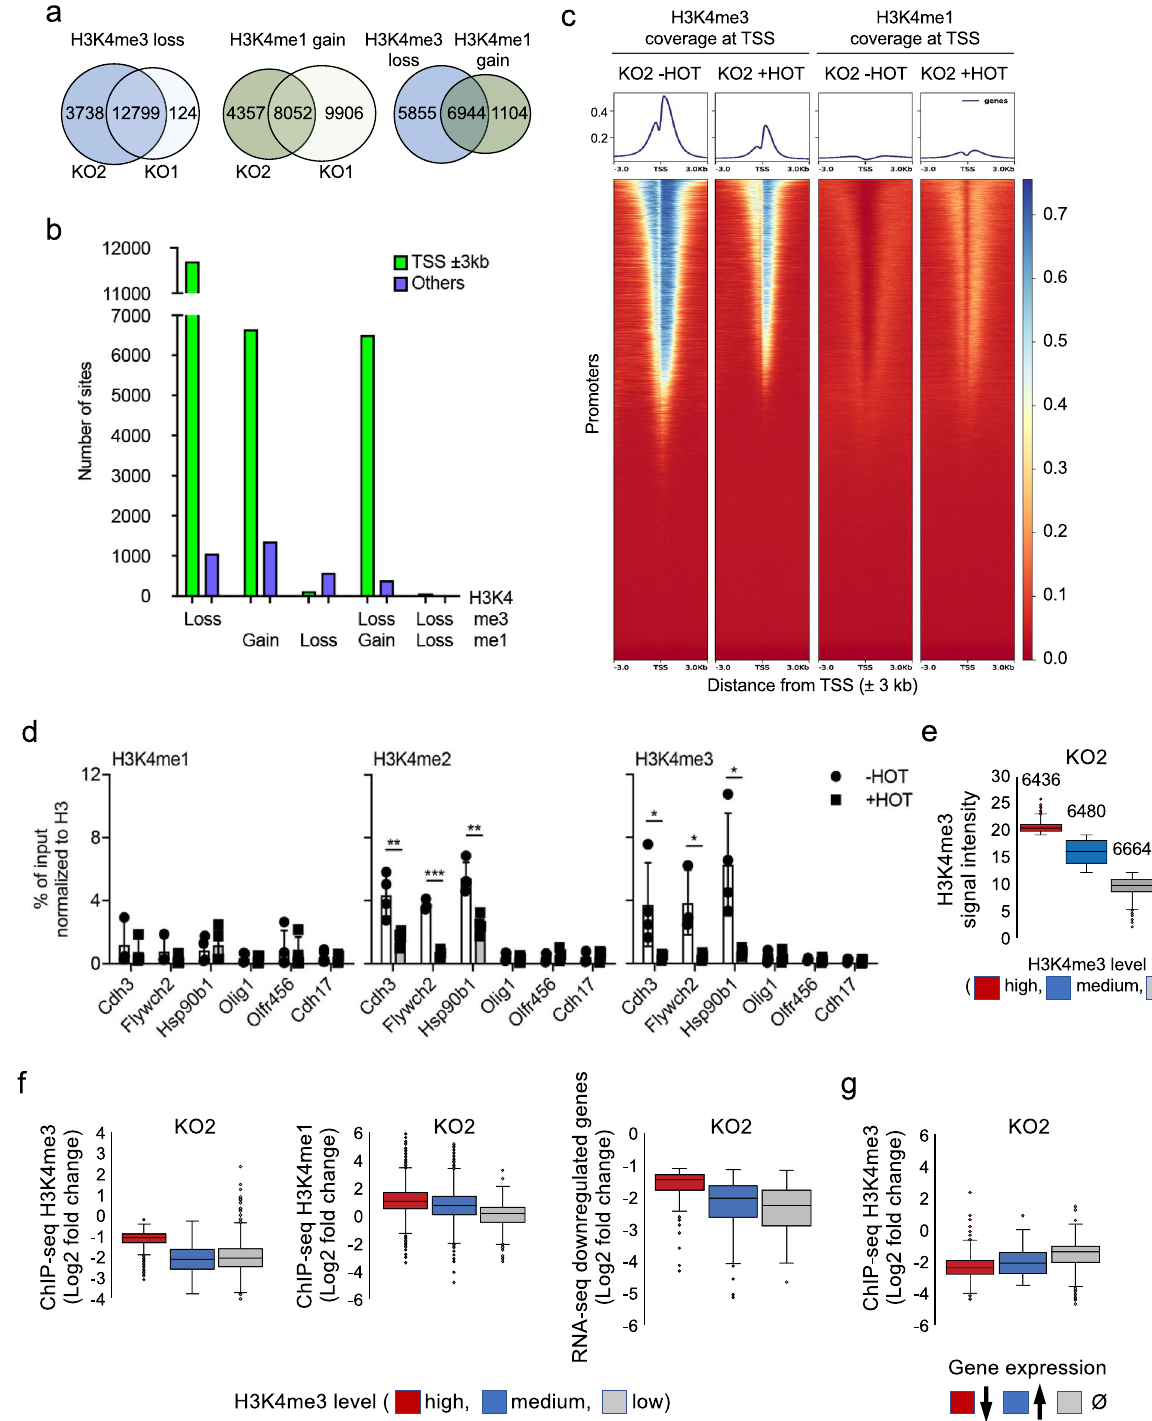
Figure 1. Deregulated H3K4me3 and me1 at promoters in response to Ash2l loss. ( a ) ChIP-seq analysis using antibodies against H3K4me3 and me1 with wild type (WT) and Ash2l fl/fl (KO) immortalized fibroblasts (iMEF1 and 2) incubated ± HOT for 5 days. The total number of sites that gain or lose signals are indicated (logFC > 0.58 and signals of > 20 reads). ( b ) ChIP-seq data as in panel A. Gained and lost H3K4me3 and me1 signals at promoters were analyzed (± 3000 bp; logFC > 0.58 and signals of > 20 reads). No gain of H3K4me3 was observed. Promoters with a loss of both marks were rare. ( c ) Heatmaps generated using DeepTools showing H3K4me3 and me1 normalized signals (normalized using counts per Million (CPM)) obtained from KO2 cells in the presence and absence of Ash2l (± HOT) at all annotated transcripts in mm9. ( d ) ChIP-qPCR experiments of KO2 cells treated ± HOT for 5 days. Mean values ± SD of 4 independent experiments measured in duplicates are displayed (* < 0.05, ** < 0.01, *** < 0.001). ( e ) Promoters were classified according to their H3K4me3 levels. Three categories were generated, the numbers of promoters in each category are indicated. ( f ) Promoters (± 3000 bp of TSS) with high, medium and low H3K4me3 signals were compared regarding alterations in H3K4me1 and H3K4me3 and changes in expression of the corresponding genes. ( g ) Genes that are up- or downregulated or did not change in expression were compared to changes in H3K4me3 at their